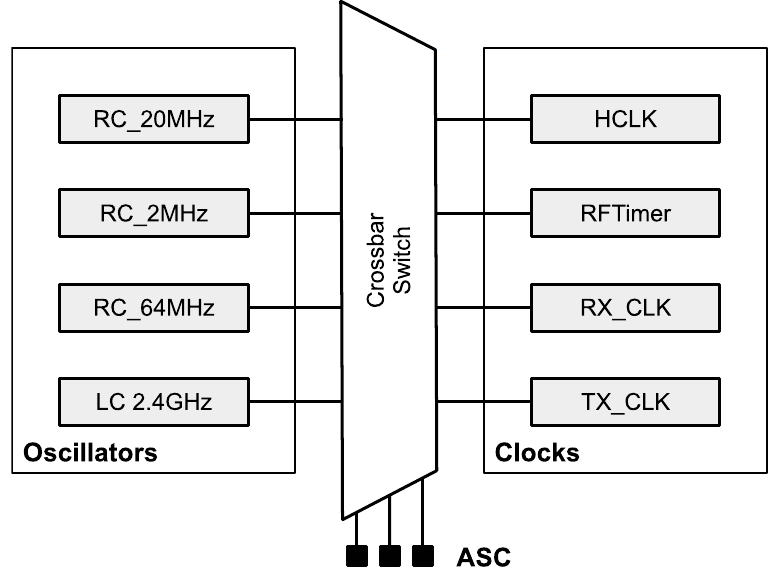
Figure 4. SCµM contains 4 main oscillators. A “crossbar switch” maps physical oscillators to clock sources that are used by the different peripherals in the chip. The Analog Scan Chain (ASC) is the mechanism for configuring this